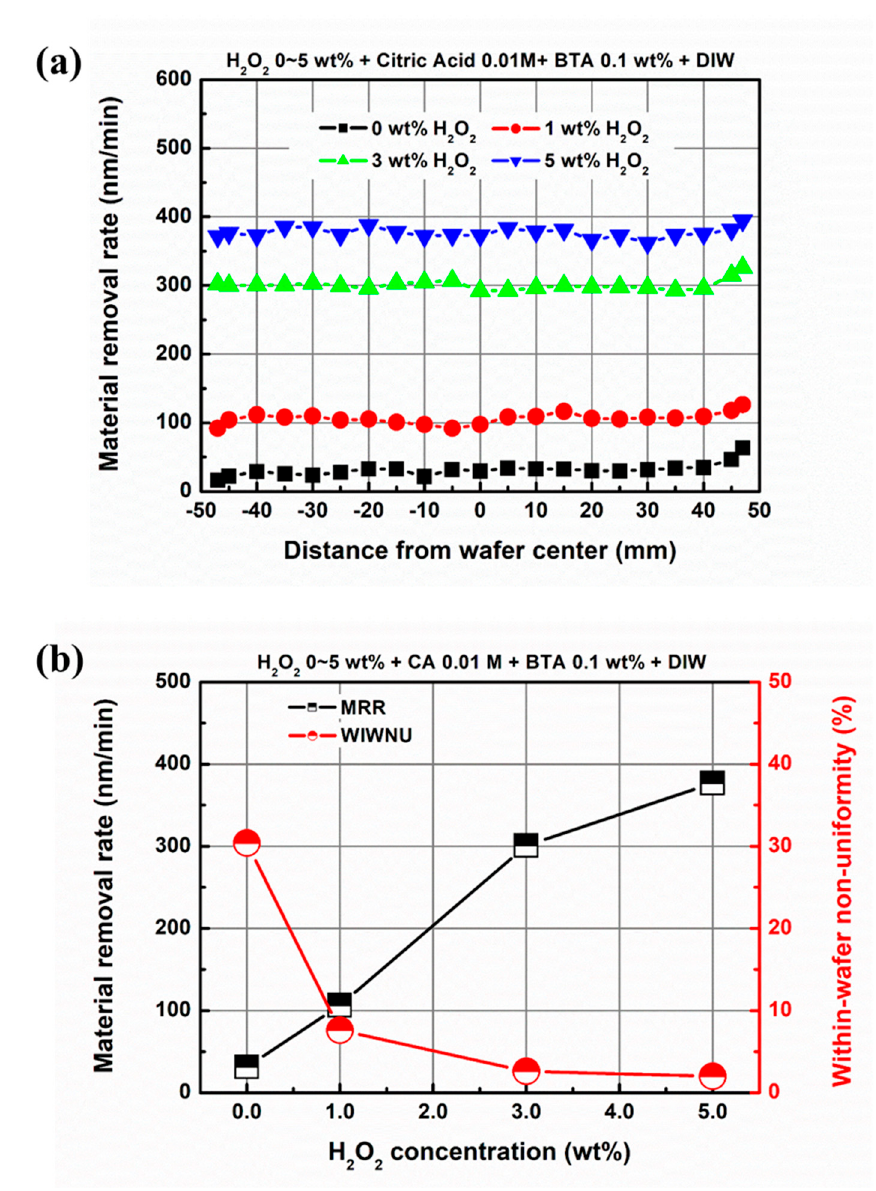
Figure 8. CMP results as a function of H 2 O 2 concentration; ( a ) MRR distribution and ( b ) average MRR and WIWNU.